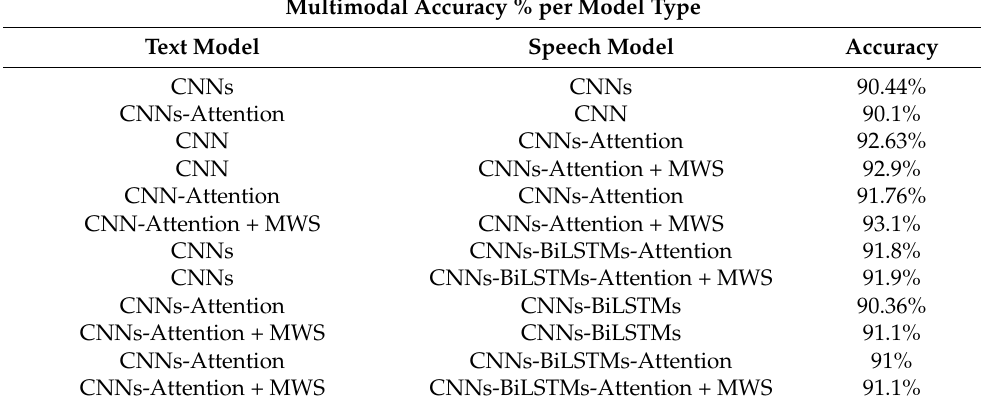
Table 4. Accuracy (Multimodal models)